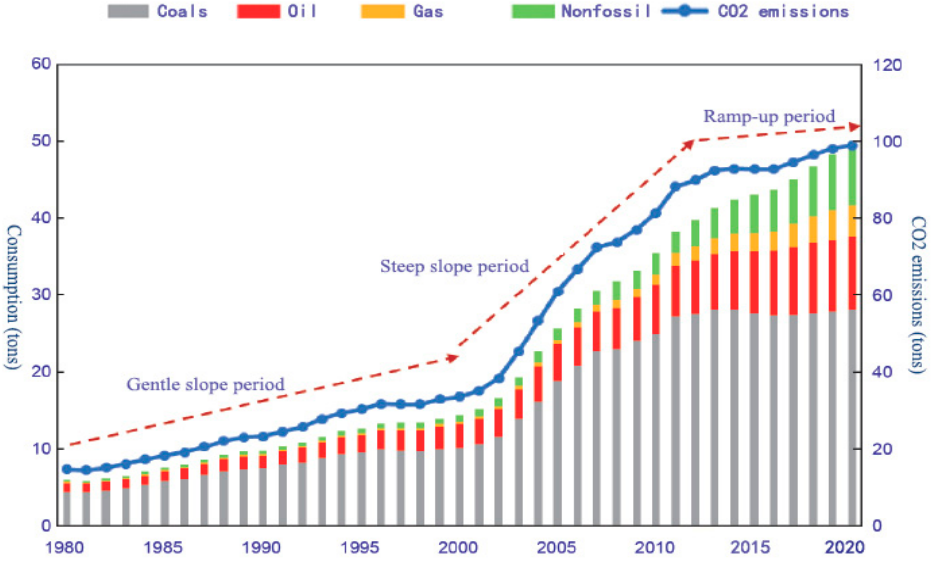
Figure 1. Carbon emission